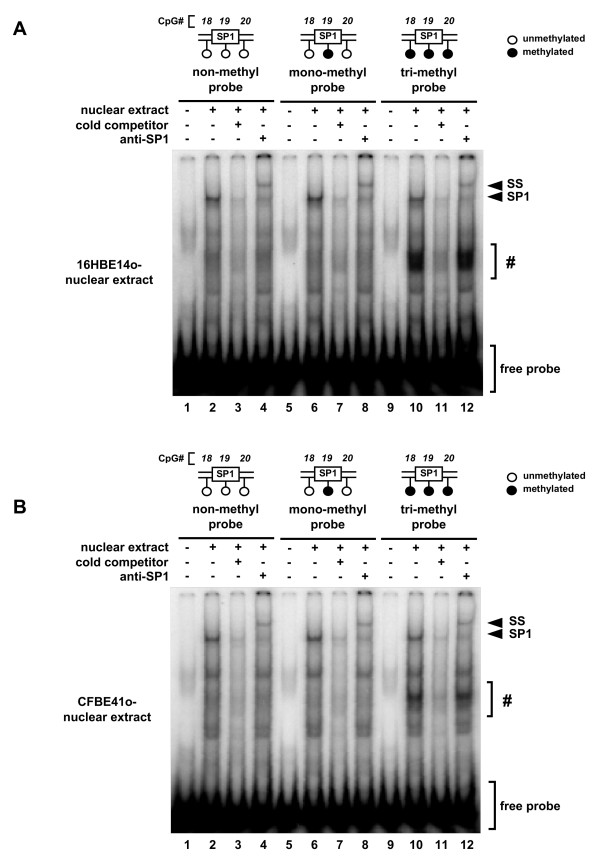
The effect of methylation on the binding of SP1 to CpG#18-20. Labeled oligonucleotides containing unmethylated, singly-methylated, or triple-methylated CpG sites were mixed with nuclear extract derived from 16HBE14o- (A) or CFBE41o- (B) cells and subjected to EMSA. Competition analysis was carried out by adding unlabeled oligonucleotides (lanes 3, 7 and 11) to the reaction solution. Supershift analysis to detect SP1-specific binding was performed using an SP1 antibody (lanes 4, 8 and 12). Arrows indicate the SP1-containing complexes (SP1) and the supershifted SP1 (SS). Bands derived from probes containing 3 methylated CpGs are indicated by (#).